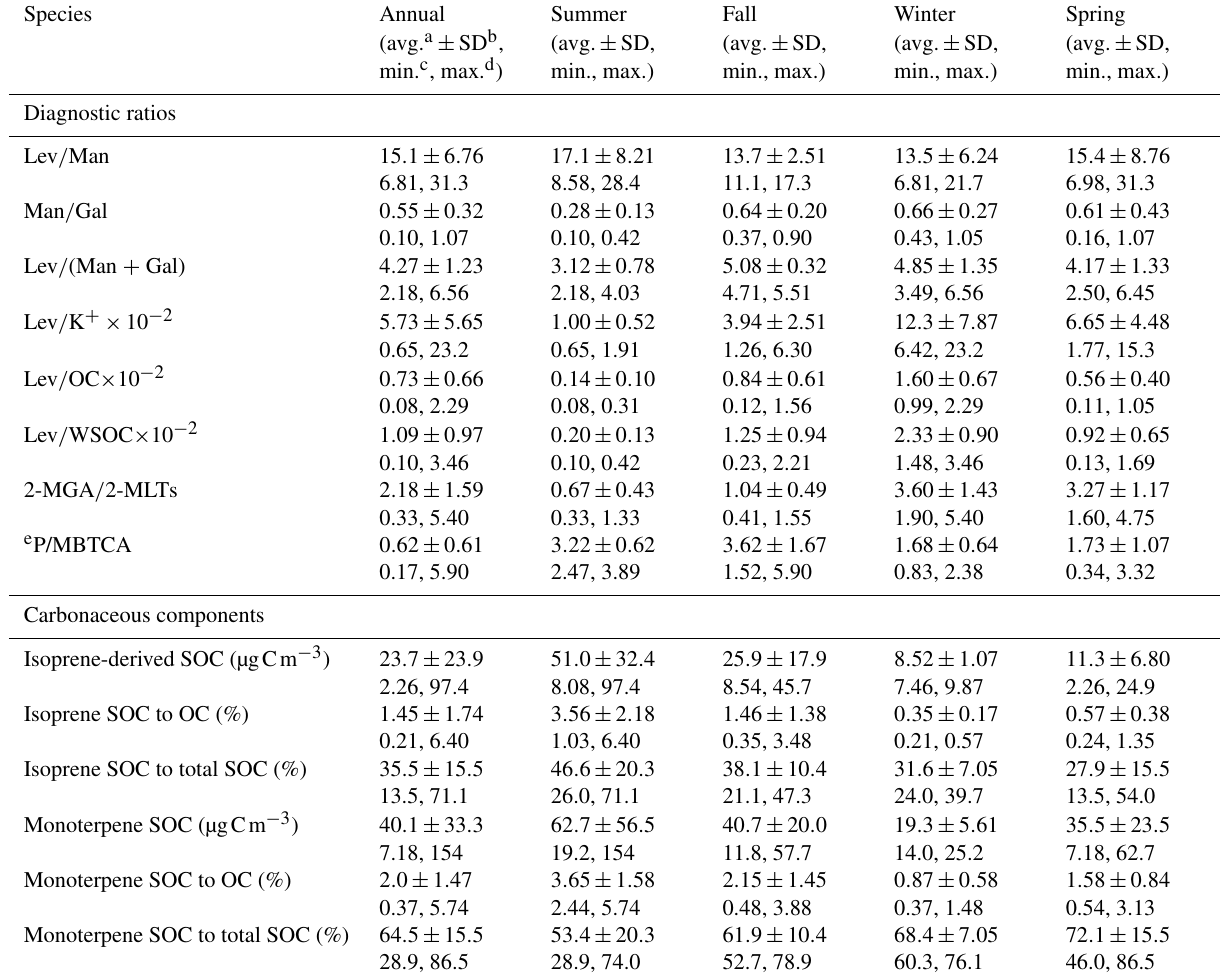
Table 2. Statistical summary of diagnostic ratios and carbonaceous components contribution in Gosan aerosols. Species Annual Summer Fall Winter Spring